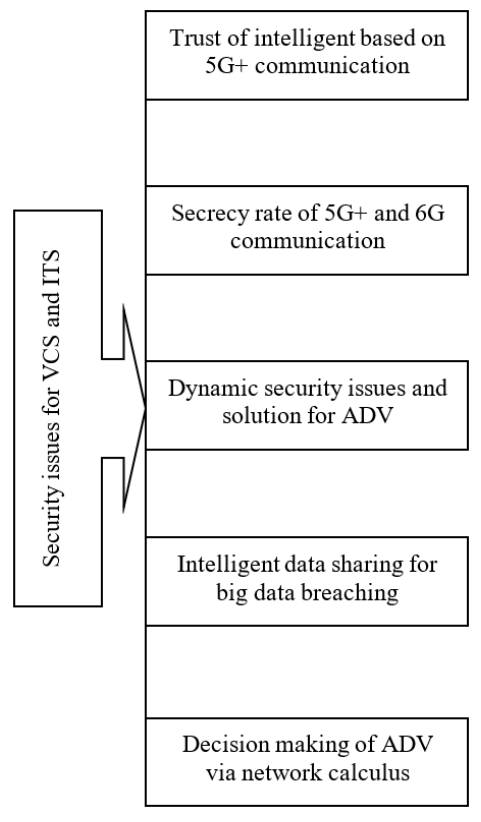
Figure 8. Open research